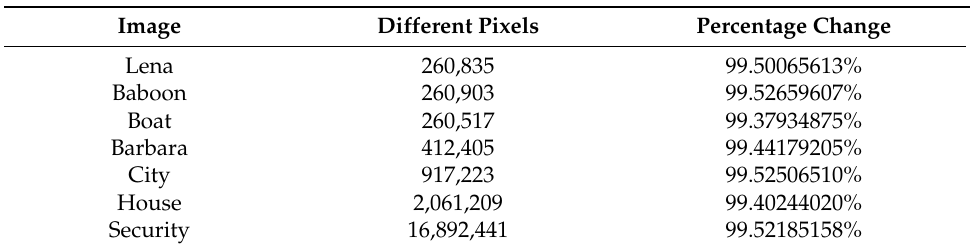
Table 11. Key sensitivity test